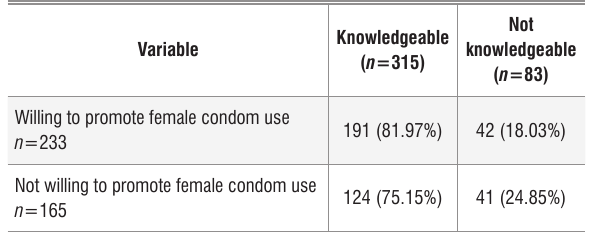
Table 5: Association between knowledge of female condoms and willing- ness to promote female condom use Variable